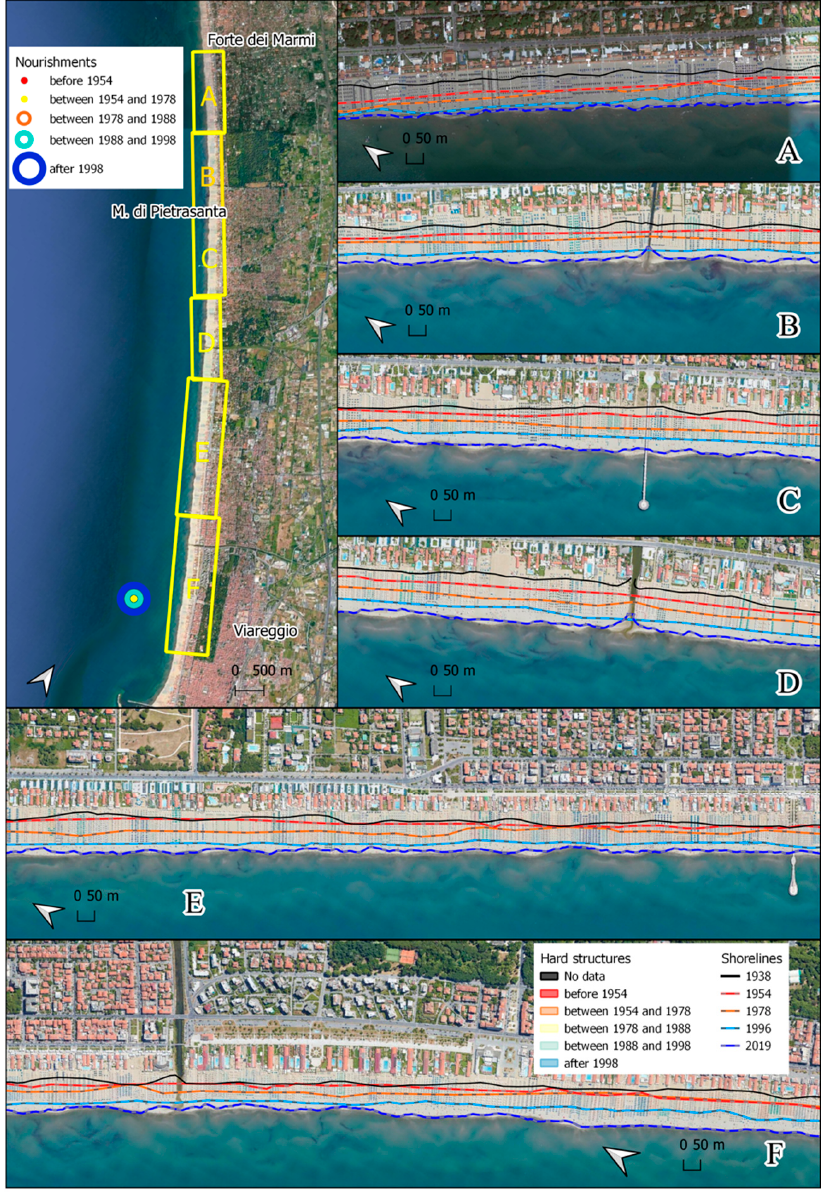
Figure 6. Identification of hard and soft operations along the sector comprised between Forte dei Marmi and Viareggio. Polygons represent the hard structures; dots represent the nourishments. The yellow frames in the top left panel correspond to the zoom in panels to the right and at the bottom. The background image has been retrieved from the Google Earth database.